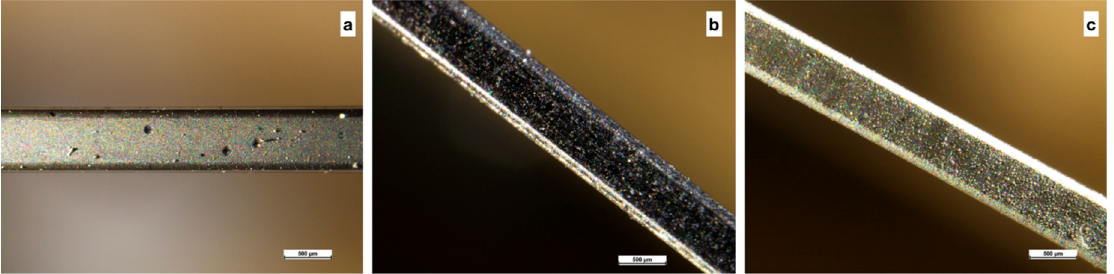
Figure 4. Coating at optical microscope ( a ) Ni, ( b ) Ni + MoS 2 , and ( c ) Ni+WS 2 .